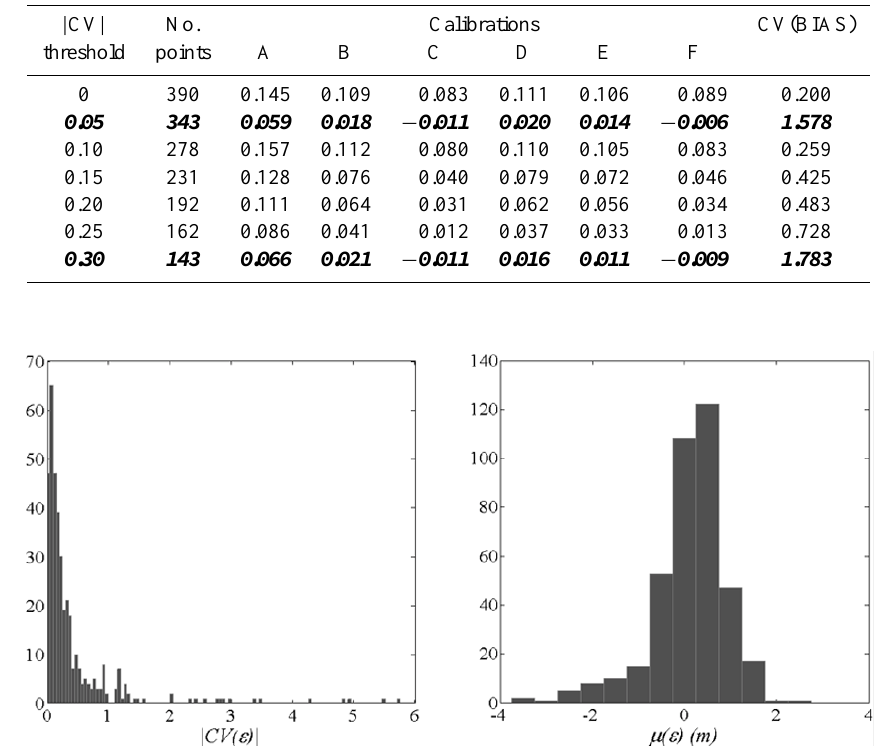
Fig. 4. Histograms of absolute coefficient variation and mean of the errors of different calibration runs for every calibration